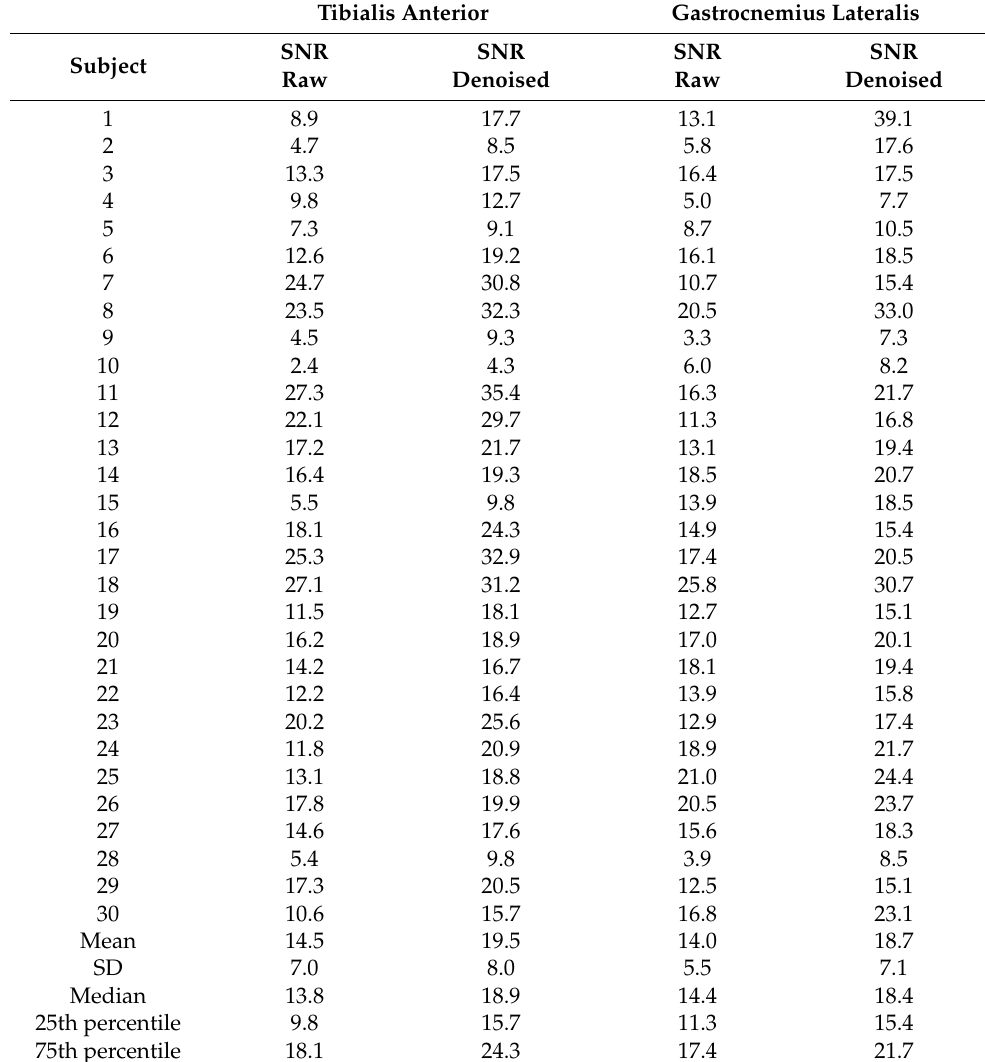
Table 2. SNR of the raw sEMG signals (SNR raw) and after CWT denoising (SNR denoised) for tibialis anterior and gastrocnemius lateralis. Tibialis Anterior